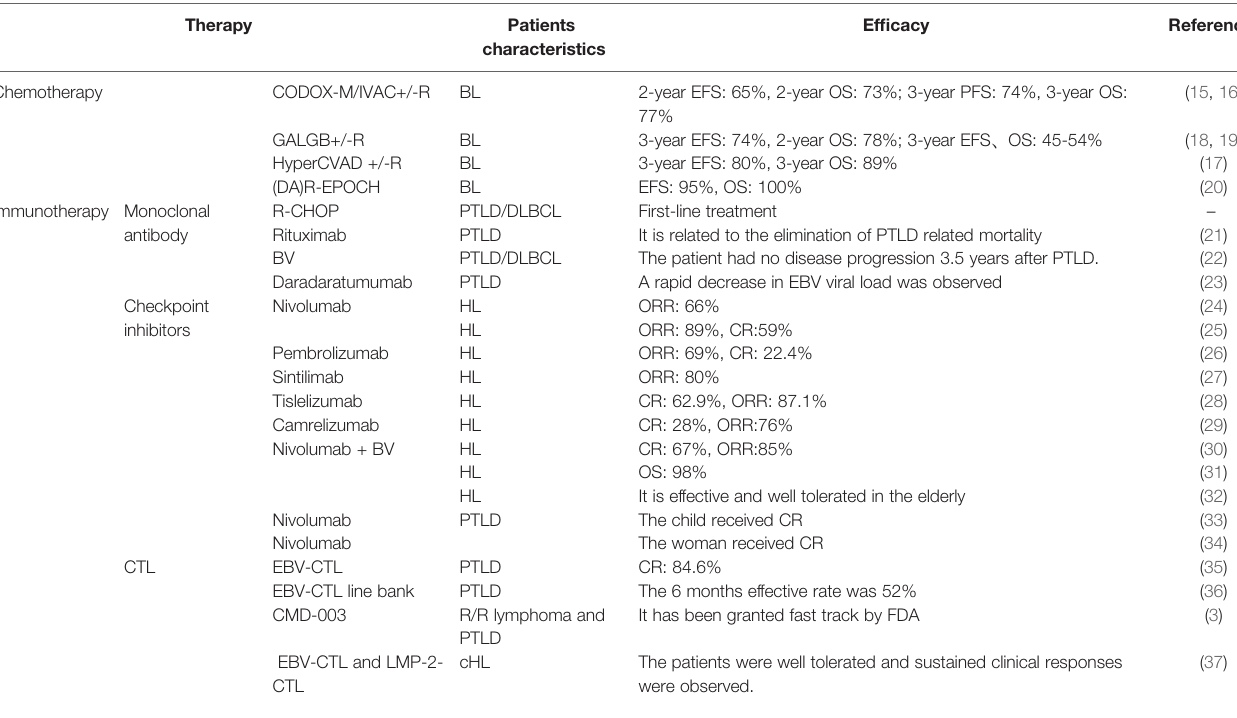
TABLE 1 | Summary of available therapies in EBV-B-LPD.